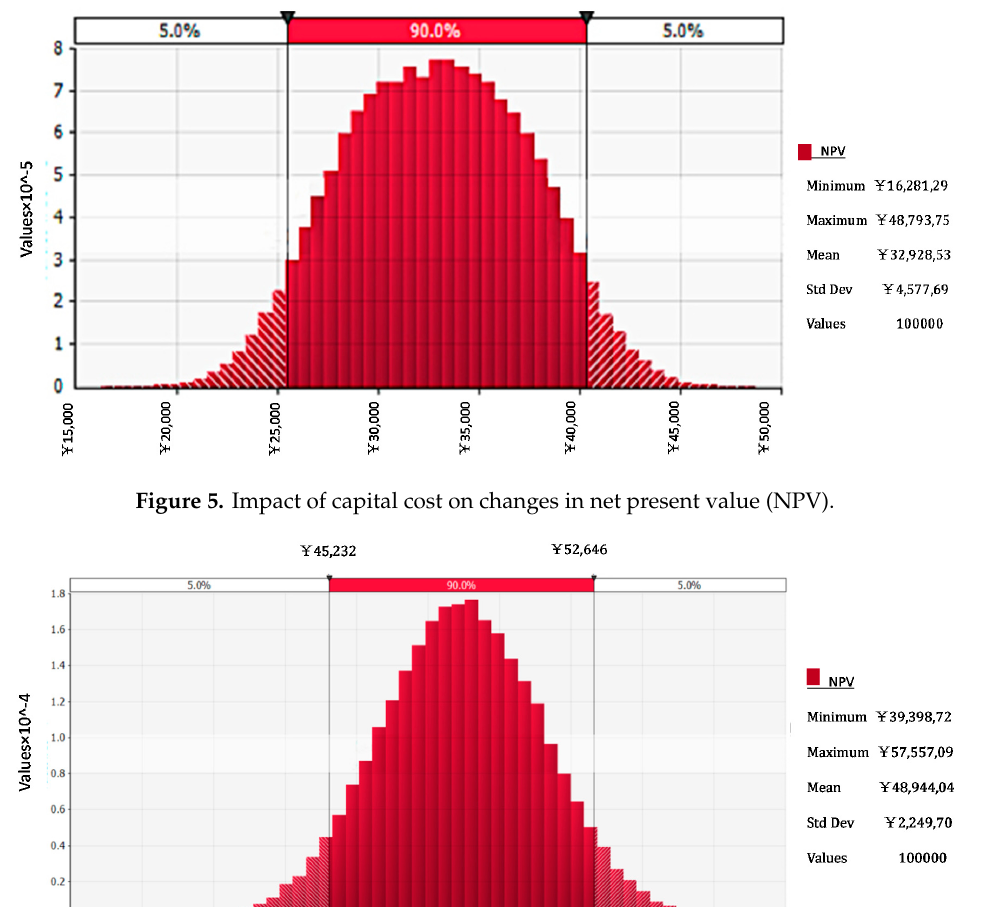
Figure 7. Comprehensive impact of changes in investment and operating costs on NPV. 4. Discussion Based on the above economic evaluation and financial risk analysis, it can be seen that the application of this technology can obtain good benefits. The probability of NPV of 355.28-623.96 million RMB is 90% and the median value is 489.42 million RMB in the 15-year life cycle of the thermal power plant. Moreover, considering the uncertainty of biomass fuel price, power generation price, and plant availability, a single factor sensitivity analysis is carried out to discuss the factors affecting NPV and IRR and their critical points. First of all, biomass fuel is the main source of cost for biomass thermal power plants. The current price of biomass fuel is 250 RMB/t and the annual fuel consumption is 500,000 tons. From the